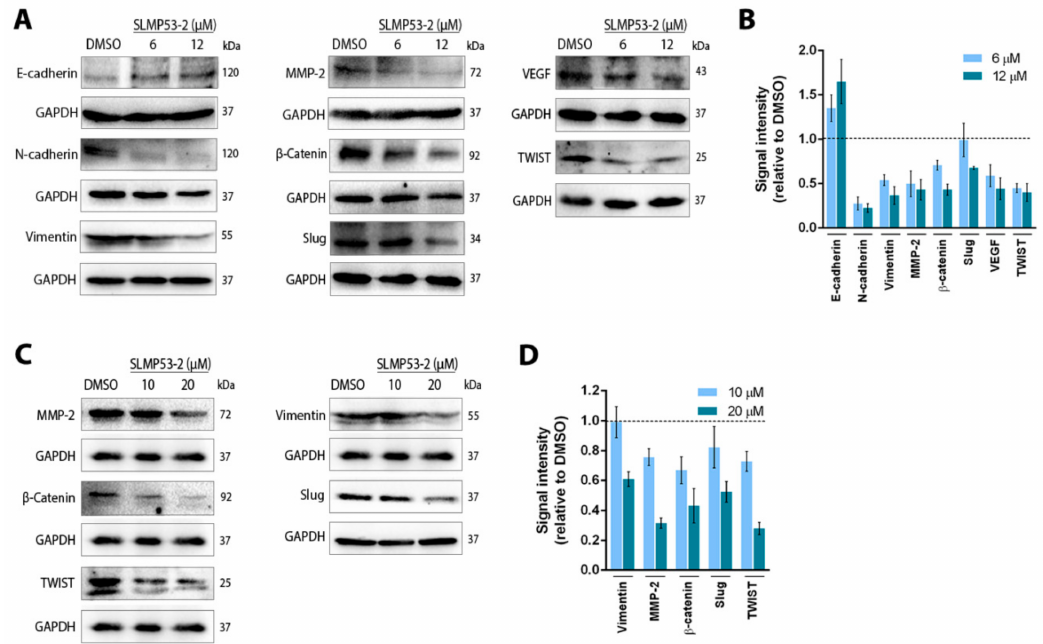
Figure 5. SLMP53-2 interferes with key molecular players in epithelial-to-mesenchymal transition (EMT) and angiogenesis. ( A – D ) Protein expression levels of crucial regulators of EMT and angiogenesis in A375 ( A , B ) and SK-MEL-5 ( C , D ) melanoma cells after 48 h of treatment with SLMP53-2 (in A375 cells, β -catenin was detected for 8 h and E-cadherin and TWIST for 24 h of treatment). Immunoblots are representative of five independent experiments; GAPDH was used as a loading control. In ( B , D ), quantification of protein expression levels is shown; values with DMSO were set as 1; data are means ± SEM, n =